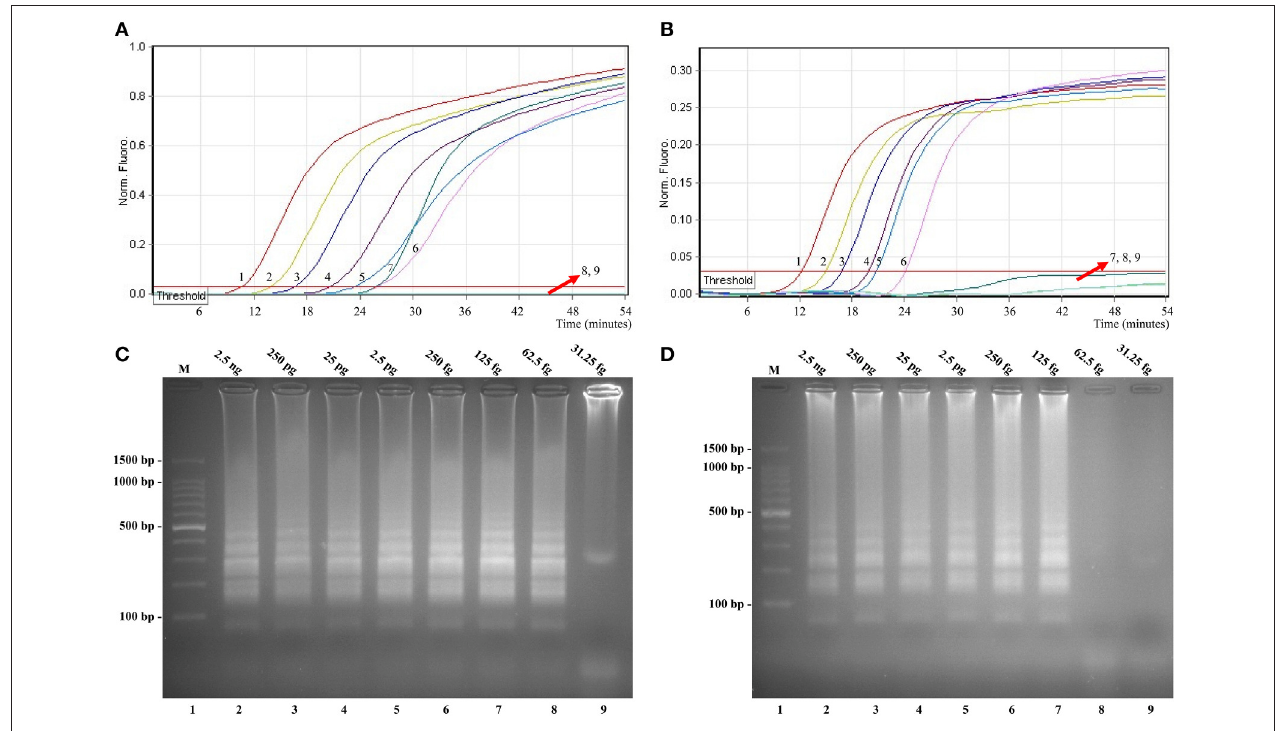
FIGURE 5 | Sensitivity of the ipaH - and invA -MERT-LAMP assays using serially genomic DNA with Shigella strains and Salmonella strains as templates. Sensitivity of ipaH -MERT-LAMP (A) and invA -MERT-LAMP (B) for Shigella and Salmonella detection was monitored by real-time format, and signals 1, 2, 3, 4, 5, 6, 7, 8, and 9 represent DNA levels of 2.5ng, 250pg, 25pg, 2.5pg, 250fg, 125fg, 62.5fg, and 31.25fg per vessel and negative control. The LoD of ipaH -MERT-LAMP assay was 62.5fg per tube, and the invA -MERT-LAMP for 125fg per reaction. Sensitivity of ipaH -MERT-LAMP (C) and invA -MERT-LAMP (D) for Shigella and Salmonella detection was analyzed by 2% agarose gel electrophoresis, and the positive amplifications were observed as a ladder-like pattern on 2% agarose gel electrophoresis analysis. Lane 1, DL 100-bp DNA marker.